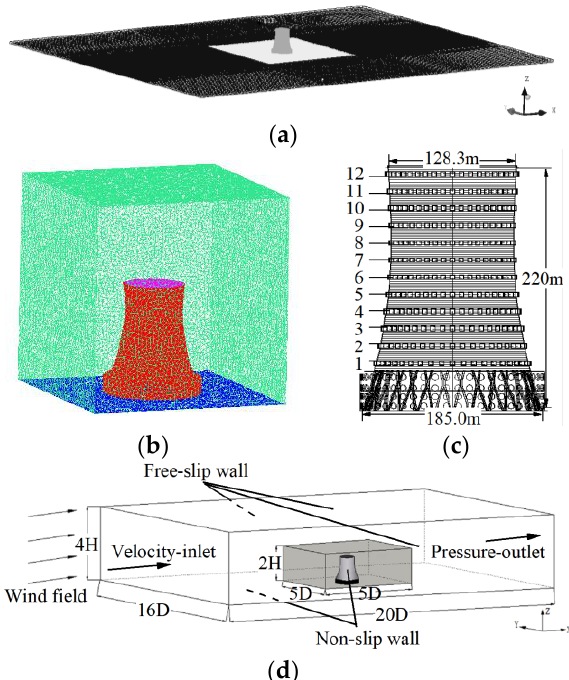
Figure 8. Schematic diagram of CFD mesh division. ( a ) Overall meshing. ( b ) Meshing of the encryption zone. ( c ) Elevation layout of measuring points. ( d ) Boundary conditions.